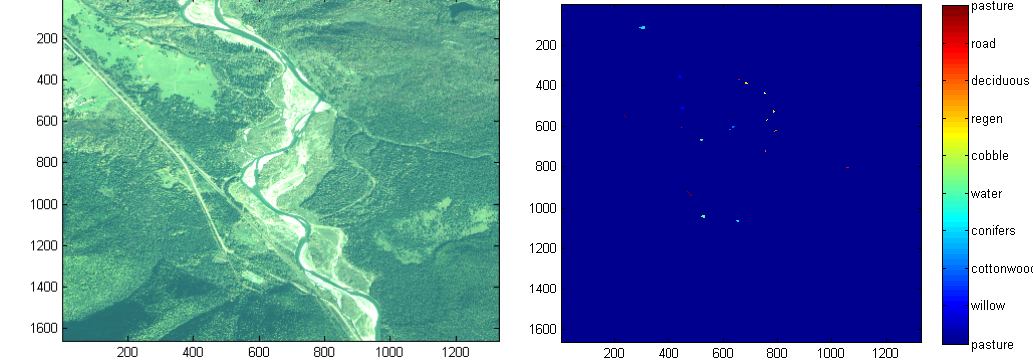
Figure 1. On the left is an image of the Nyack flood plain located on the Middle Fork of the Flathead River, Montana. On the right, the polygons denote the location of the training data set, taken from the image on the left.